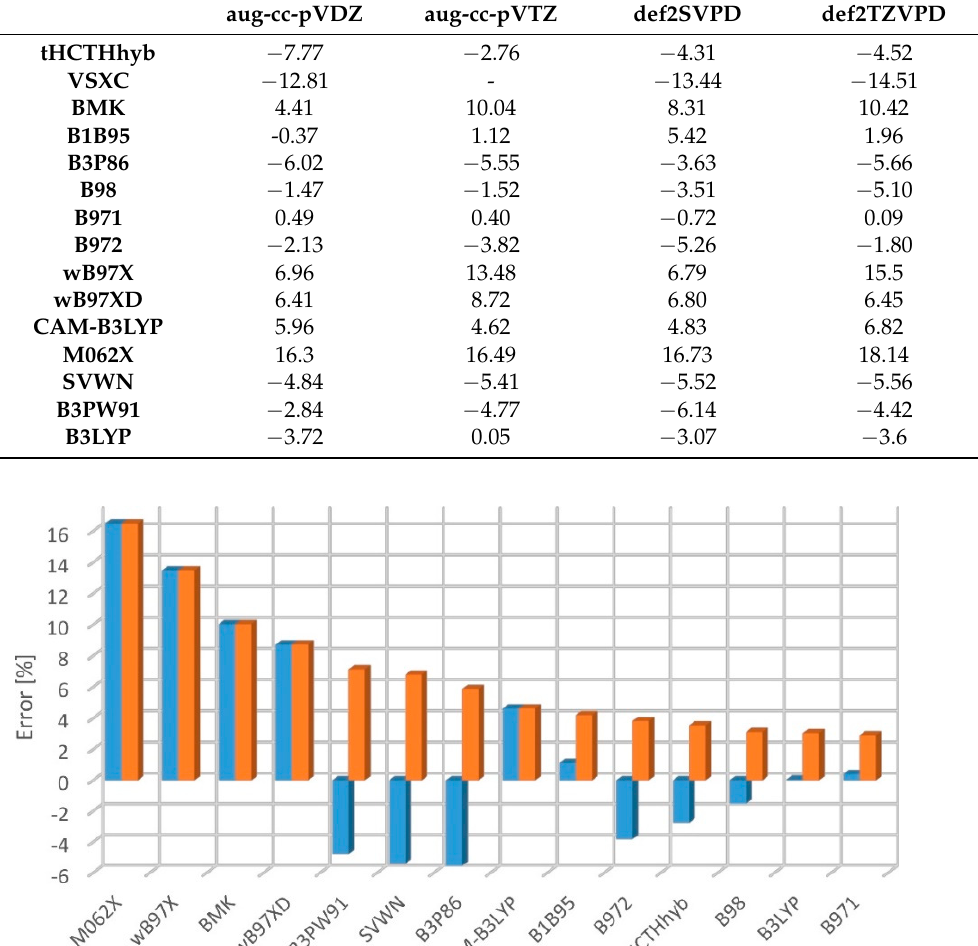
Table 3. Mean percent errors (with respect to the measured Ar-matrix values) of the singlet-triplet excitation energy calculations performed with various functional/basis set combinations. See Table S3 for ∆ st , and ∆ abs (defined by Equations (3) and (4)).